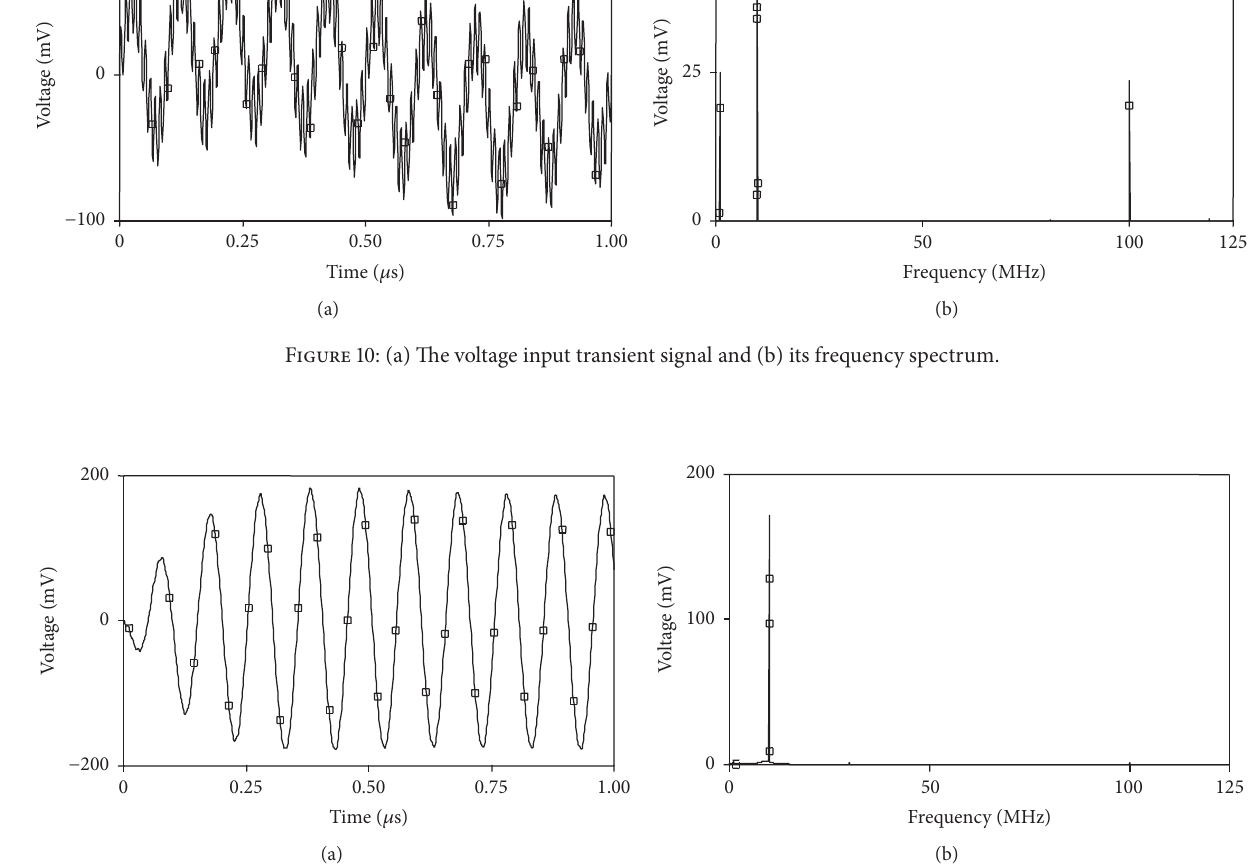
Figure 11: (a) The voltage output transient signal and (b) its frequency